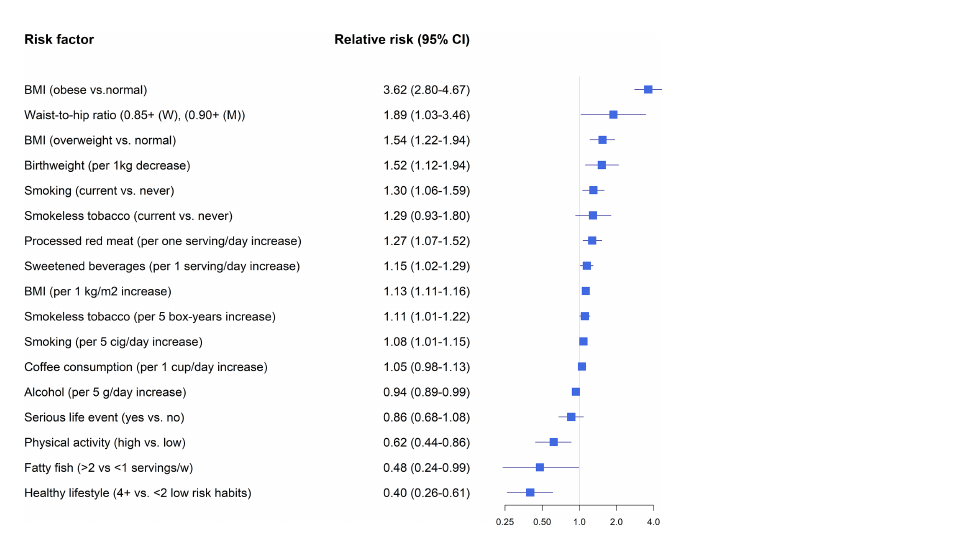
FIGURE 1 | Lifestyle factors and LADA- fi ndings from observational studies. Relative risk estimates extracted from references (28, 36, 39 –